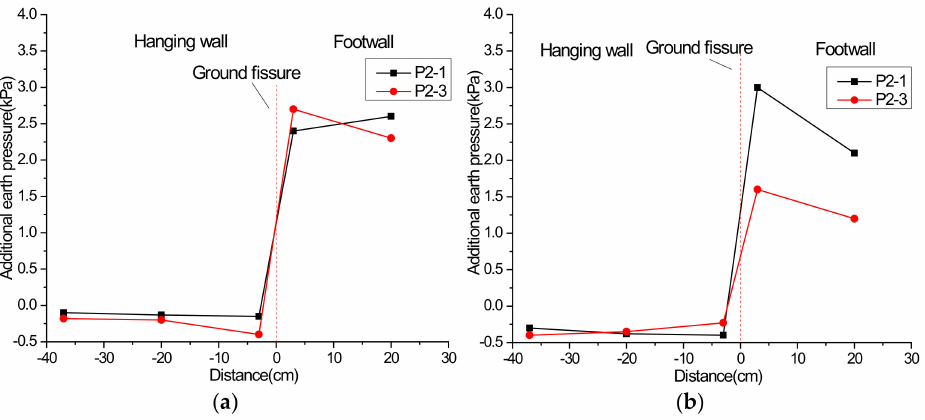
Figure 20. Additional earth pressure at 50 cm height under the scenario of hanging wall